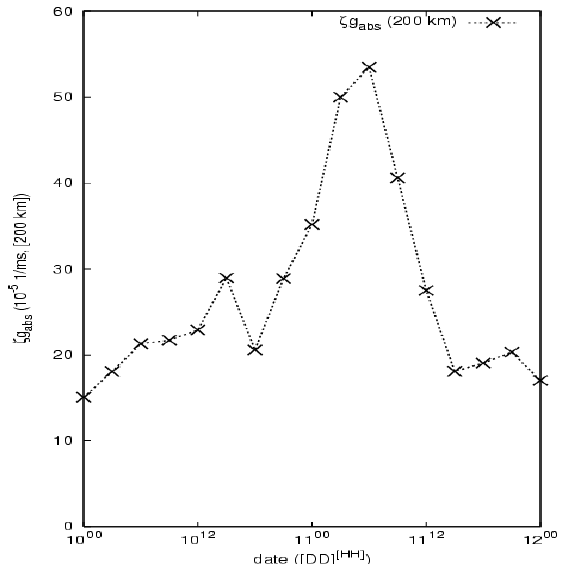
Fig. 5. Evolution of the geostrophic vorticity calculated at 200km (defined as in Campins et al., 2000), using a constant Coriolis value of C 0 = 8 . 25 × 10 − 6 s − 1 , and density ρ = 1 . 225kgm − 3 .